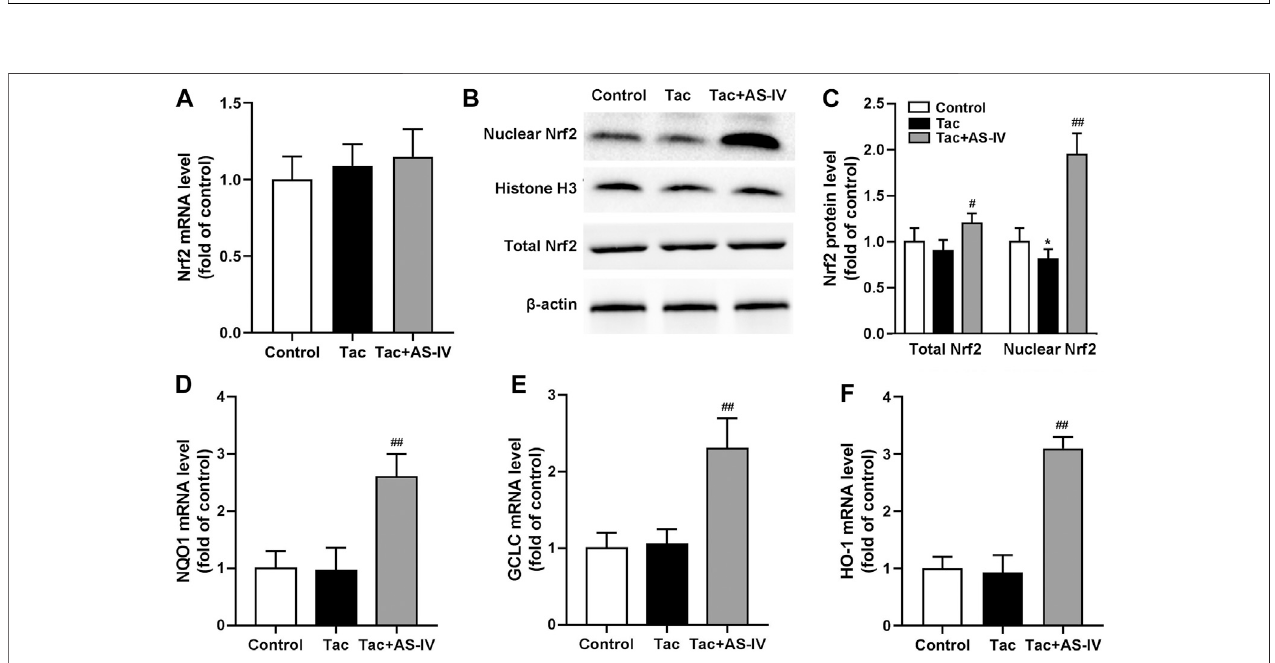
FIGURE 4 | Astragaloside IV induced Nrf2 nuclear translocation and down-stream genes transcription in vivo . The mice were treated with tacrolimus ± Astragaloside IV for 4 weeks, and then renal tissues were taken to evaluate the effects of Astragaloside IV on the Nrf2 mRNA levels ( n (cid:1) 8) (A) , the nuclear and total Nrf2 protein levels ( n (cid:1) 6) (B) – (C) , the mRNA levels of NQO1 (D) , GCLC (E) and HO-1 (F) ( n (cid:1) 8). * p < 0.05 vs. the Control group; # p < 0.05 and ## p < 0.01 vs. the Tac group.